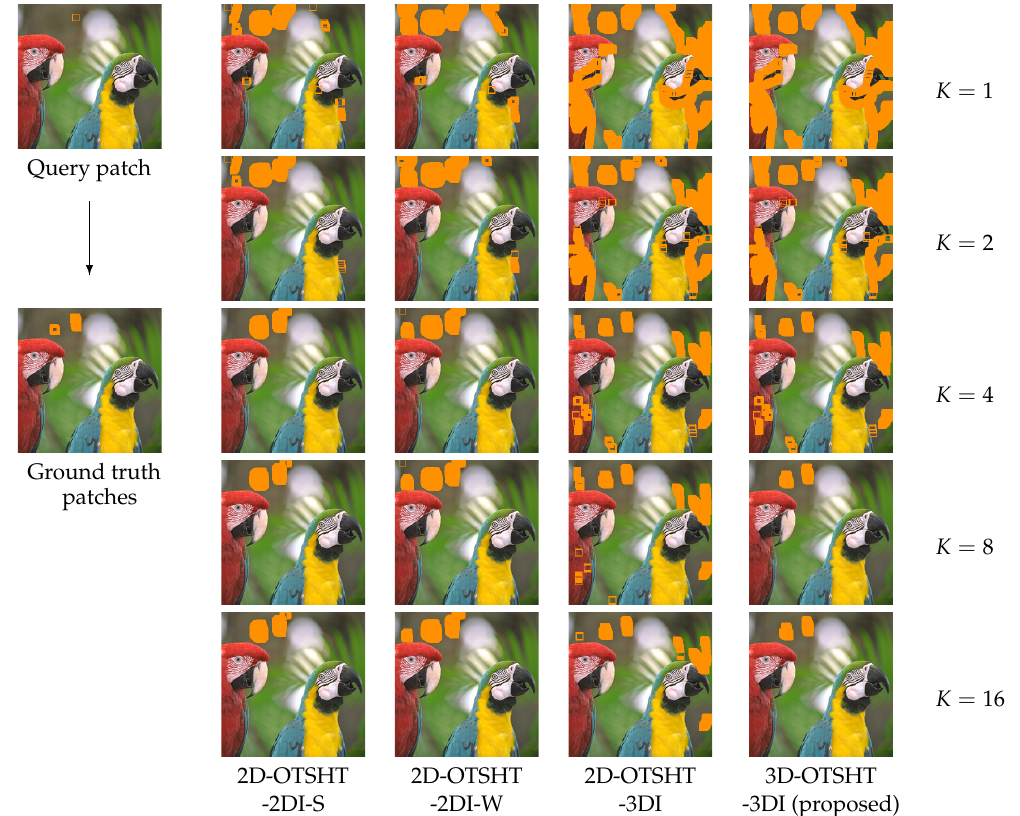
Figure 6. An example of the patches detected by a query patch in different methods at K basis images/blocks. The query patch of size 13 13 and the detected patches are shown in orange squares. ×